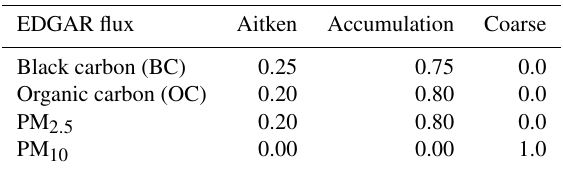
Table 1. Fractional assignment of EDGAR particulates to Aitken, accumulation and coarse modes.